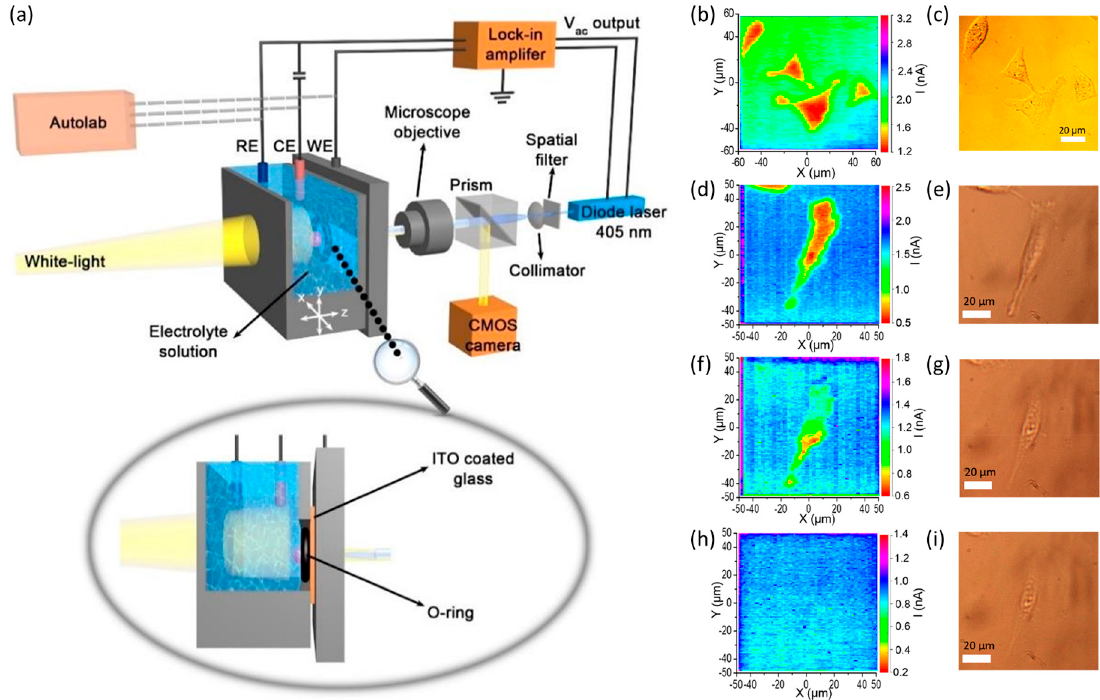
Figure 4. ( a ) Schematic of the PEIS set-up with ITO coated glass; ( b ) photocurrent image by PEIS and ( c ) optical image by camera of MG63 human osteosarcoma cells; ( d ) PEIS image and ( e ) optical image of hMSC before TX-100 addition; ( f ) PEIS image and ( g ) optical image after 30 min incubation with 0.04% TX-100 in DPBS; ( h ) PEIS image and ( i ) optical image after 200 min incubation with 0.04% TX-100 in DPBS. Reprinted from Wu et al. [116].